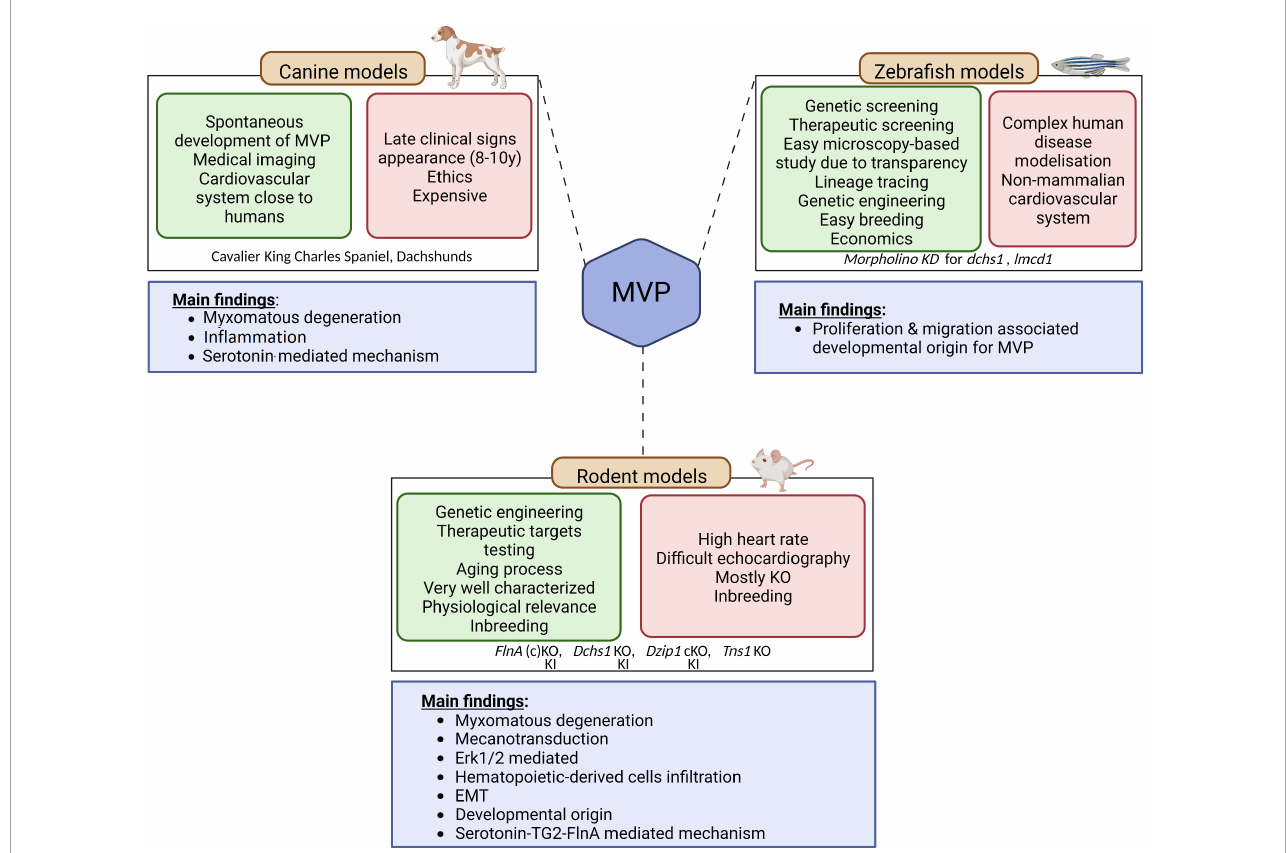
FIGURE3 Animal models of MVP. Three main categories of animal models are currently available to study MVP, the canine model, the rodent model, and the zebrafish model. The advantages of each are presented in the green squares and downsides are presented in the red squares. The main finding coming out of the models are depicted in the blue square underneath. EMT, endothelial to mesenchymal transition; KO, knock-out; KI, knock-in; MVP, mitral valve prolapse; SERT, serotonin transporter; TG2, transglutaminase 2. Created with